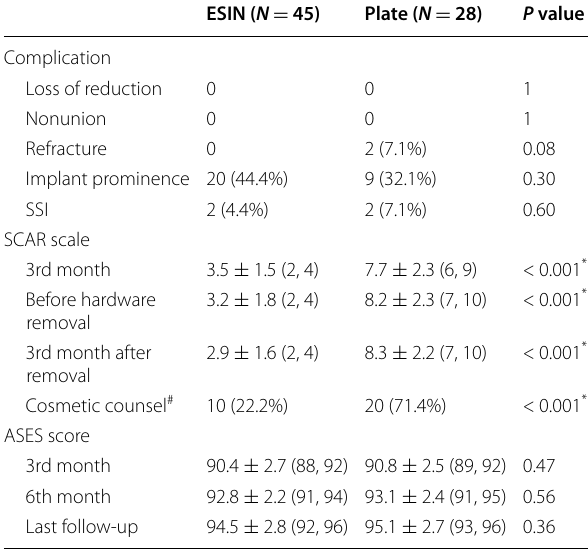
Values of ontinuous variables are described as mean ESIN elastic stable intramedullary nail, SSI surgical site infection, SCAR Scar Cosmesis Assessment and Rating, ASES American Shoulder and Elbow Surgeons * P 0.05 ≤ # Cosmetic counsel was sought due to esthetic